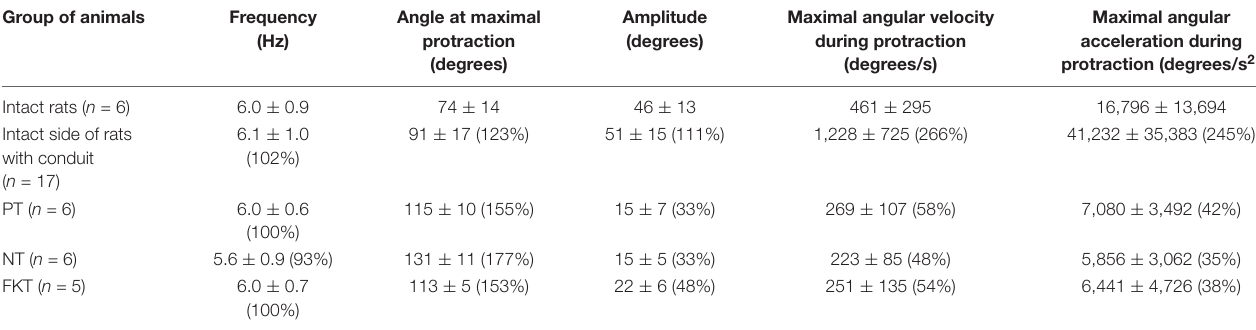
Maximal angular during protraction acceleration during protraction (degrees/s 2 )